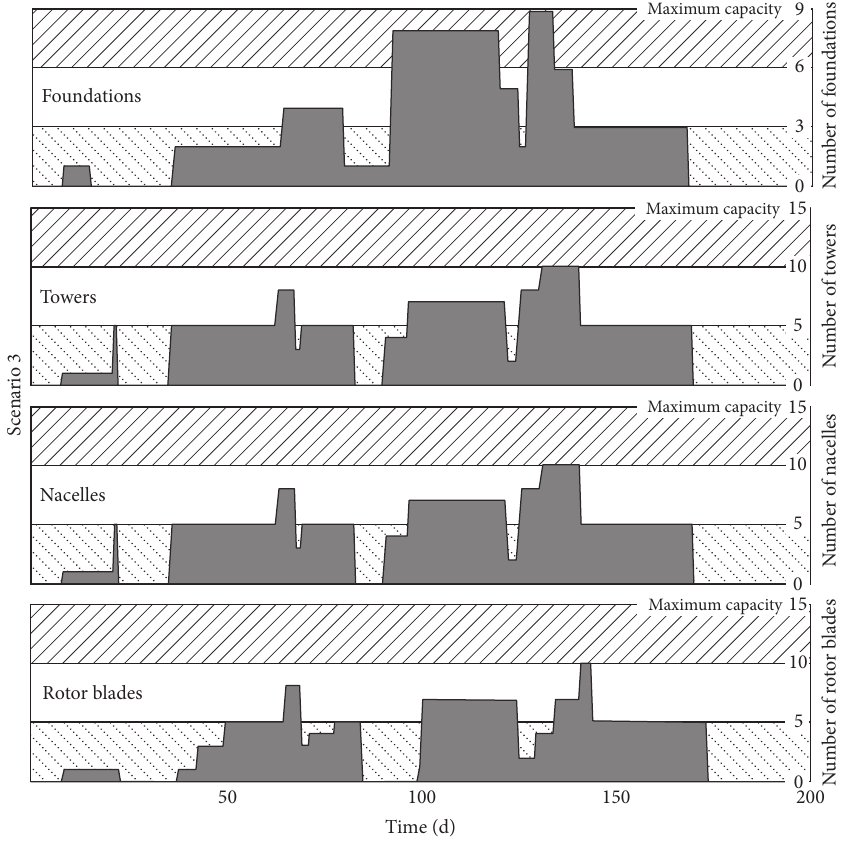
Figure 6: Simulation results of Scenario